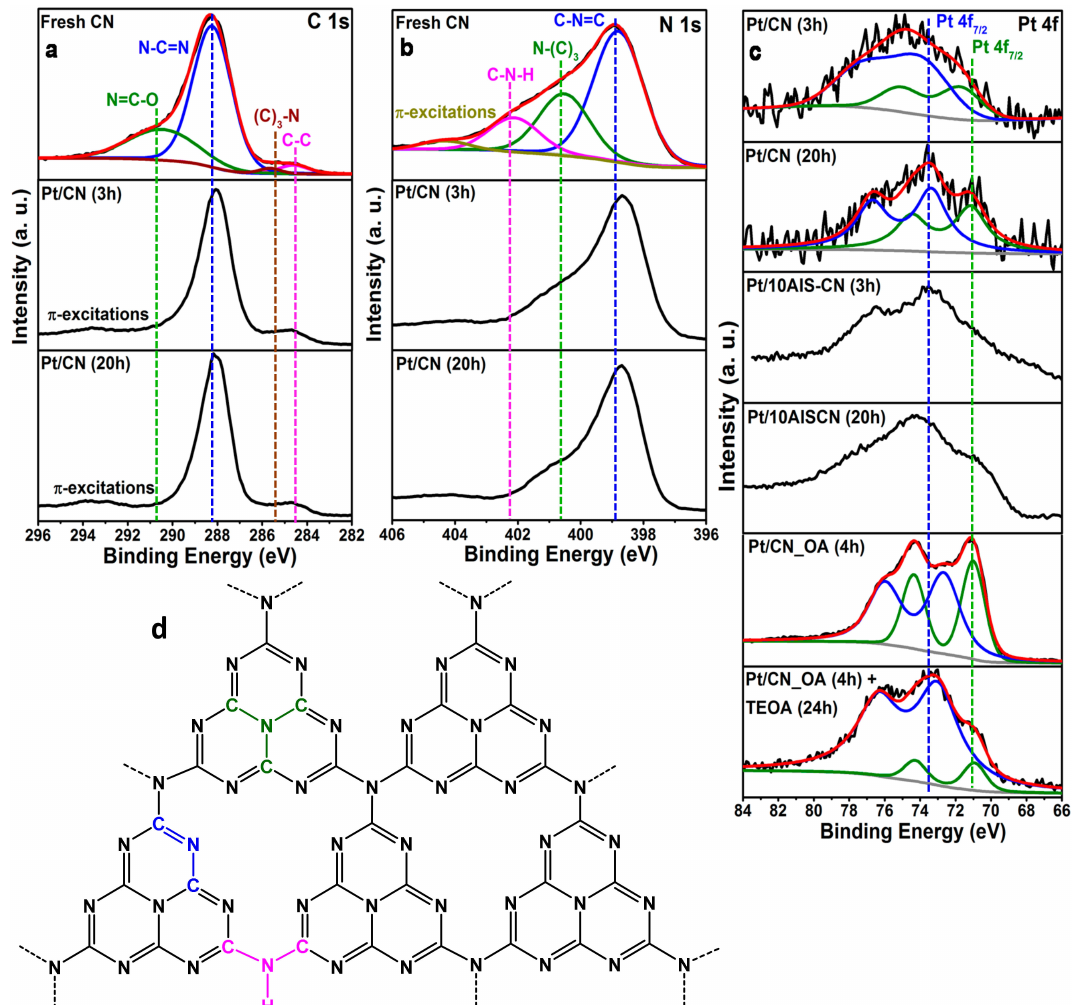
Figure 3. XP spectra of selected samples in the C 1s ( a ), N 1s ( b ) and Pt 4f region ( c ) blue: Pt 2+ , green: Pt 0 together with a scheme of the C 3 N 4 structure ( d